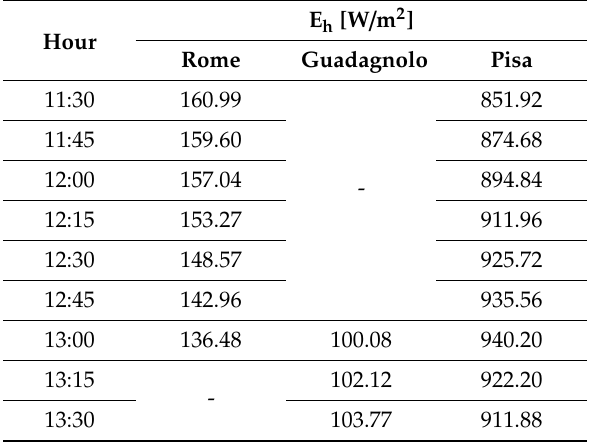
Table 8. E h values of the three considered sites used as input data for the algorithm.